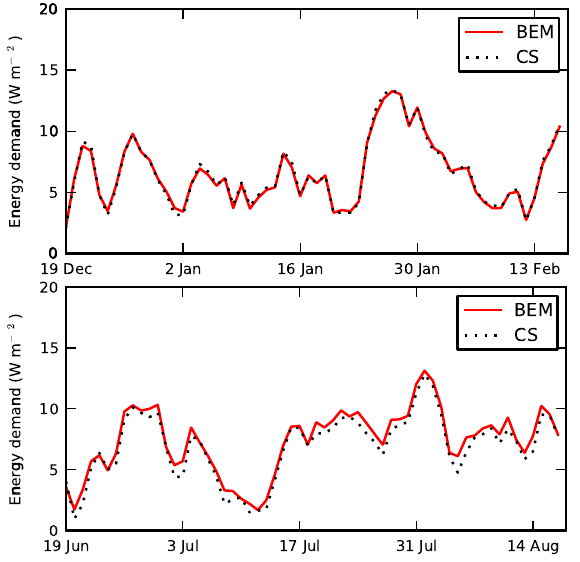
Fig. 6. Daily-average heating (top) and cooling (bottom) energy demand per unit of floor area for winter and summer calculated by the coupled scheme and by BEM-TEB for the dense urban centre of Toulouse.